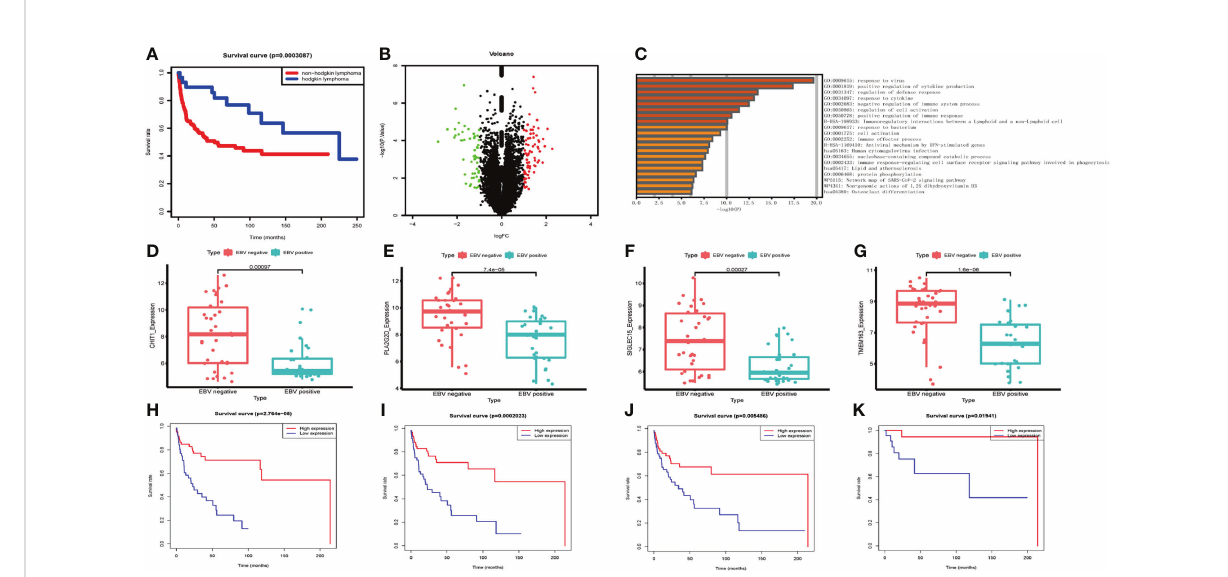
FIGURE 4 The expression levels of differential genes in fl uencing the survival of NHL patients. (A) Survival analysis of lymphoma patients between NHLs and HLs. (B) Volcano plot of differential genes in EBV- and EBV+ lymphoma group. (C) Functional enrichment of differential genes bases on Metascape database. (D – G) The box plot shows the expression levels of four differential genes between two groups in NHLs. (H – K) Correlation of differential gene expression level with overall